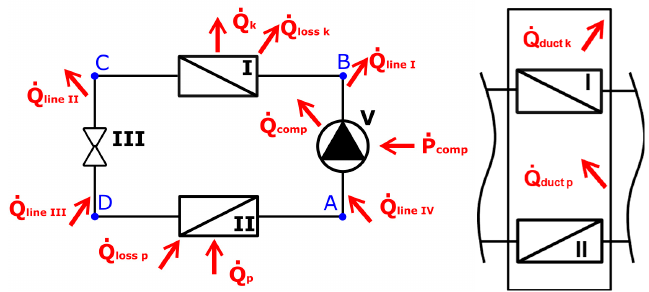
Figure 6. Energy losses or gains in the tested